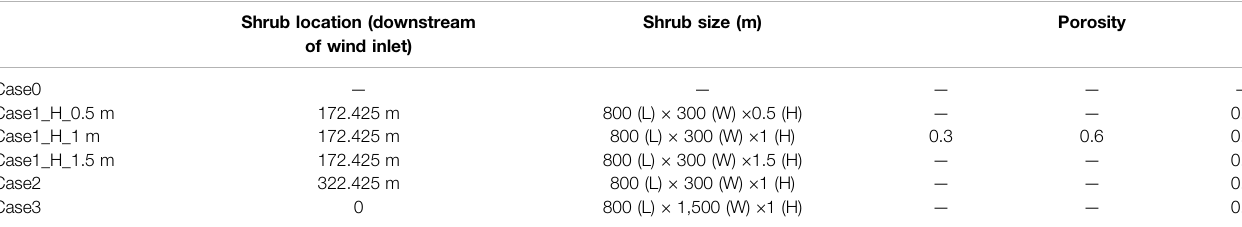
TABLE 2 | Speci fi c parameters of the four computed cases. Shrub location (downstream of wind